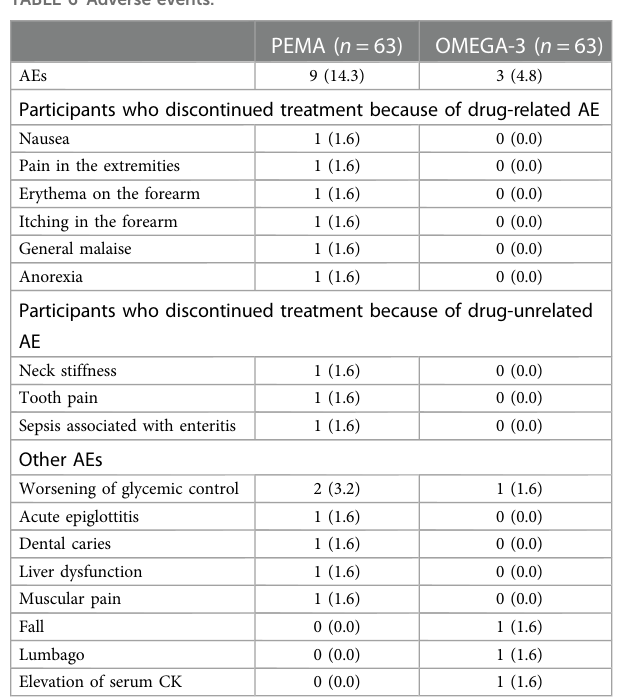
TABLE 6 Adverse